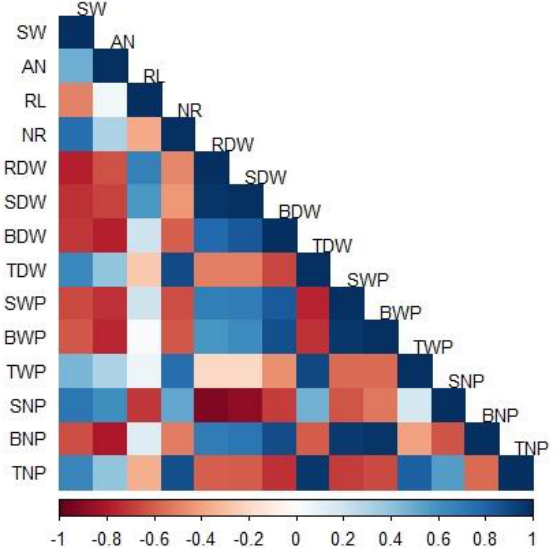
Figure 6. Correlation analysis ( n = 30) of soil water content (SM), available nitrogen (AN, mg kg −1 ), the root length (RL, cm), nitrate reductase (NR, μg g −1 FW h −1 ), root dry matter (RDM, g plant −1 ), stem and leaf dry matter (SDM, g plant −1 ), bud and boll dry matter (BDM, g plant −1 ) and total dry matter (TDM, g plant −1 ) with nitrogen productivity and water productivity at pre-sowing irrigation (W 80 ) or no pre-sowing irrigation and base fertilizer surface (F 10 ) or deep (F 30 ) application with 2016. RWP, root water productivity (g DM cm −3 ); SWP, stem and leaf water productivity (g DM cm −3 ); BWP, bud and boll water productivity (g DM cm −3 ); TWP, total water productivity (g DM cm −3 ); RNP, root nitrogen productivity (g DM mg −1 ); SNP, stem and leaf nitrogen productivity (g DM mg −1 ); BNP, bud and boll nitrogen productivity (g DM mg −1 ); TWP, total nitrogen productivity (g DM mg −1 ).